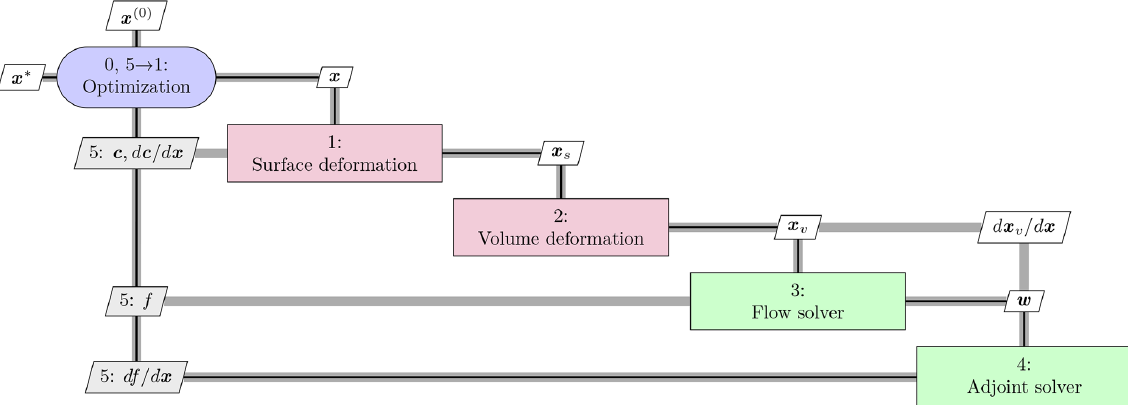
Figure 1. Extended design structure matrix (XDSM) showing the optimization framework. Green blocks are iterative solvers, whereas red boxes represent explicit functions. Black lines represent the process flow in the order of the numbers; gray lines represent data dependencies.